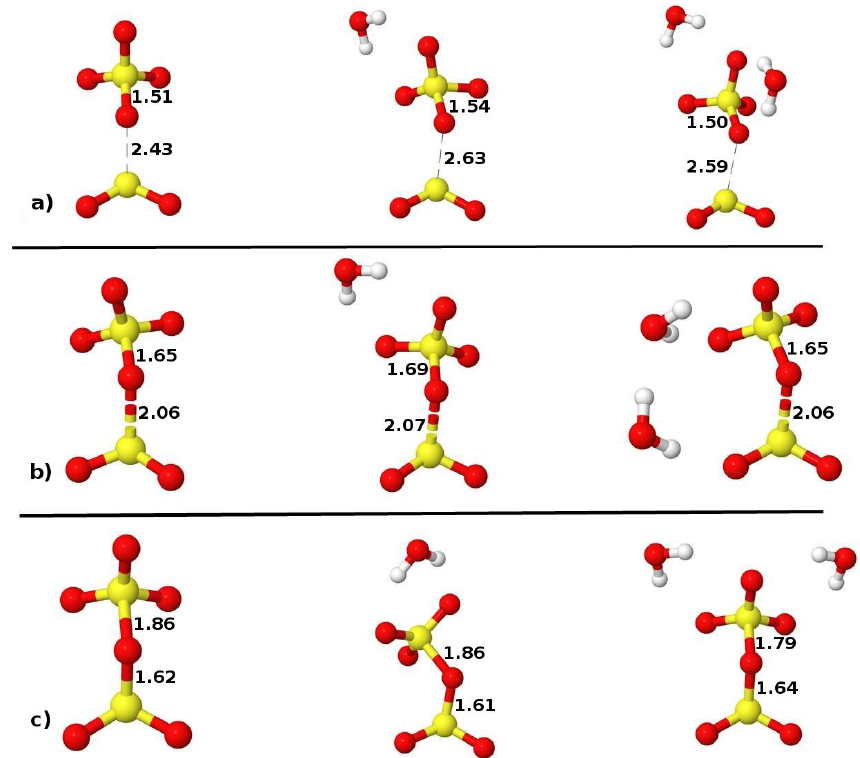
( H 2 O ) 0 − 2 , (b) TS, and (c) SO 3 SO − ( H 2 O ) 0 − 2 . Descriptive bond 4 3